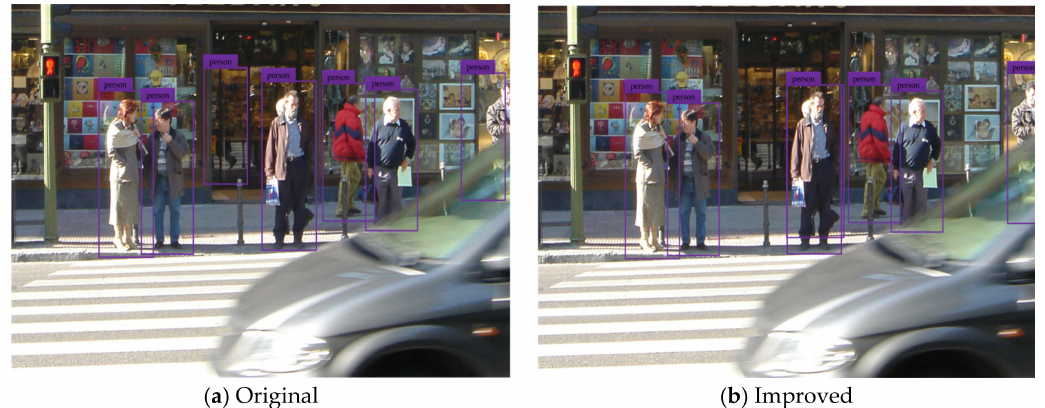
Figure 7. Pedestrian detection test results in the multi-scale scenario.